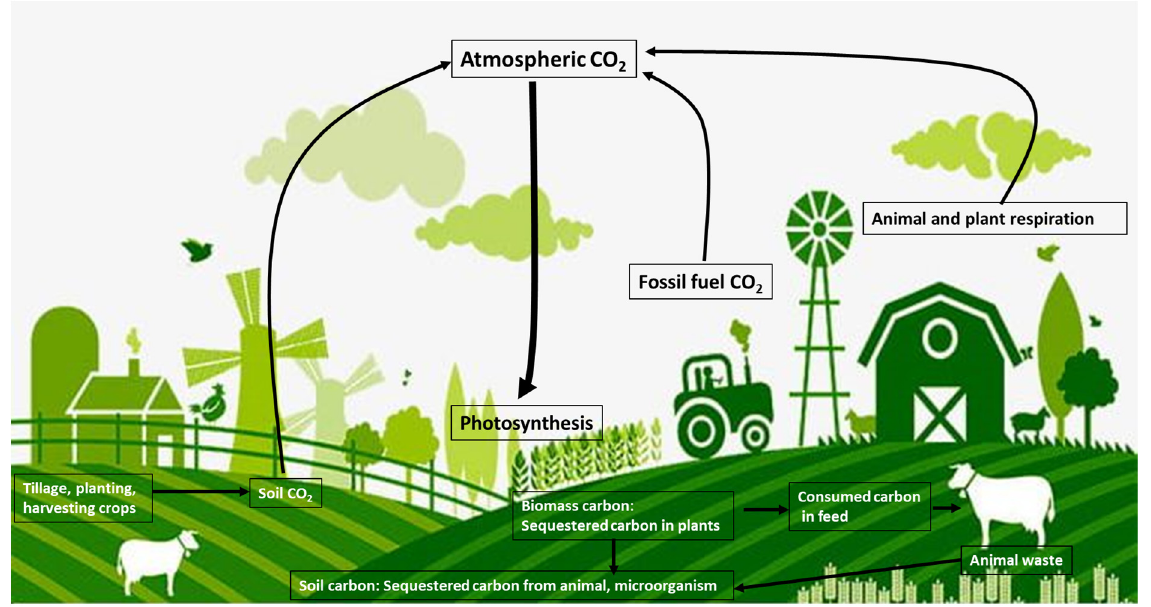
Figure 2. Carbon cycle demonstrating both additions to and removal of atmospheric carbon dioxide (CO 2 ). CO 2 is also produced by the long transport routes involved in food distribution.